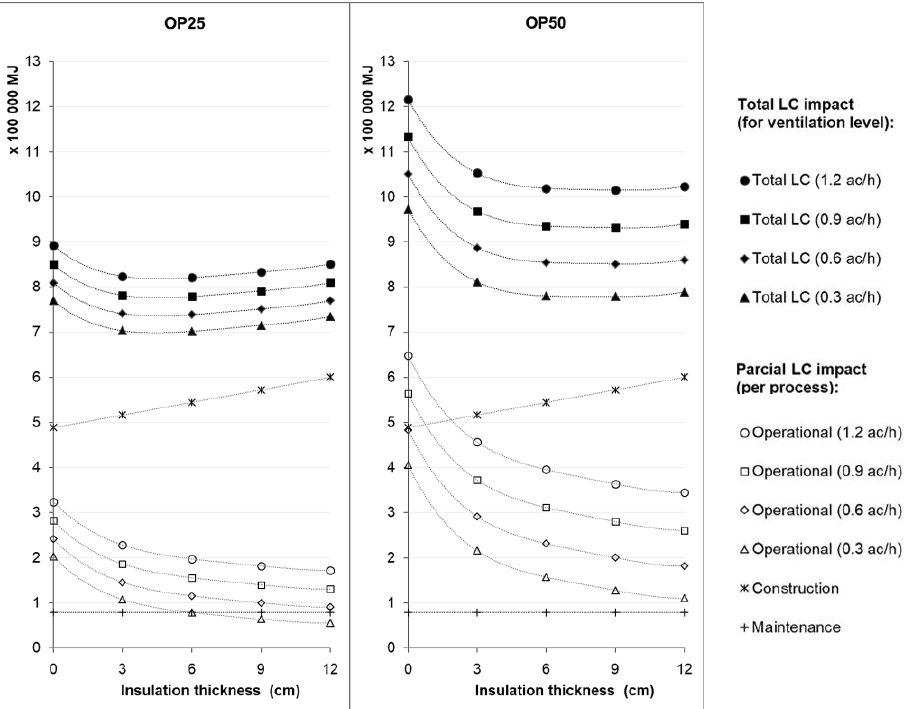
Figure 1. NRPE results for base case house with a heat pump for OP25 and OP50: ventilation level vs. insulation level.